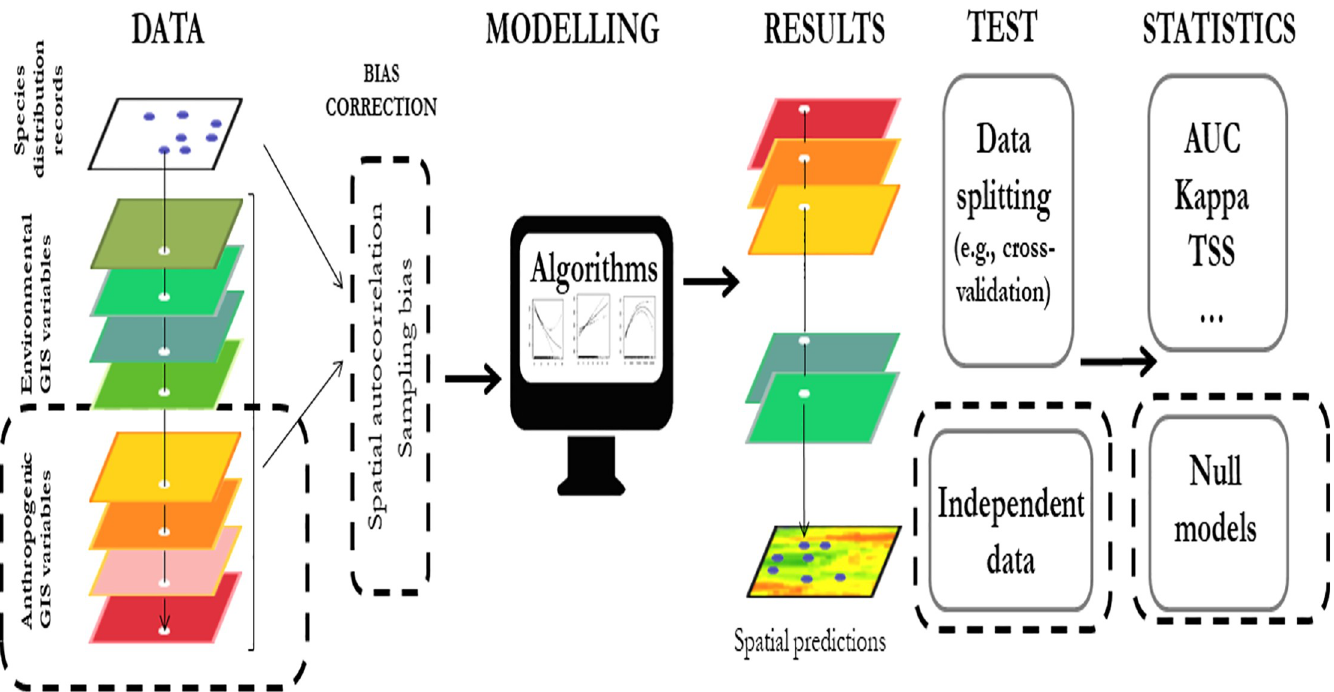
Fig 1. Diagram of the Species Distribution Modelling procedure. Dashed boxes mark the parts of the approach that have been improved in our study as compared to the common procedure.